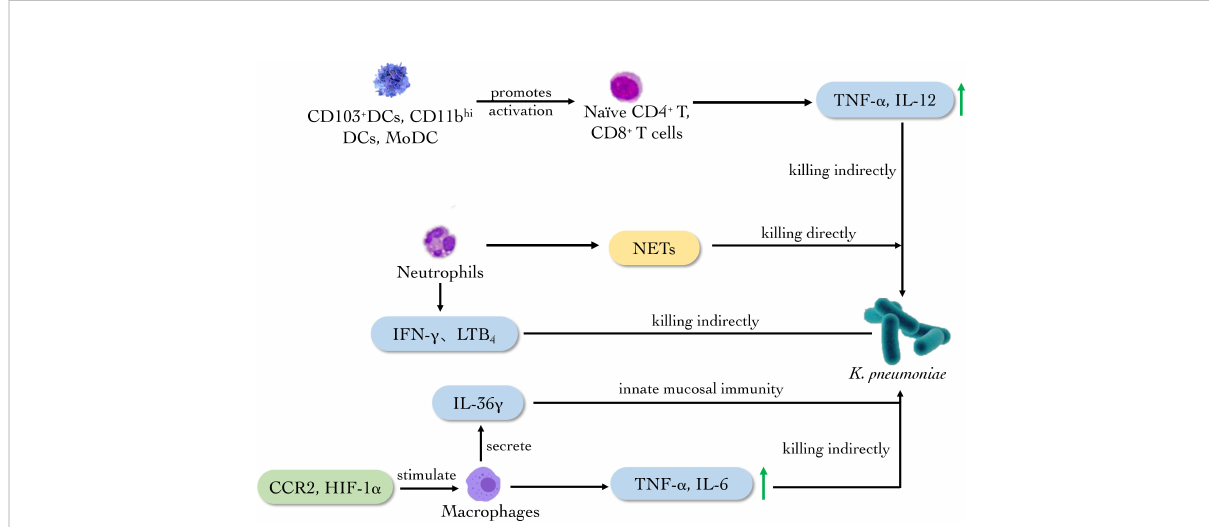
FIGURE 4 The main role of innate immune cells against K. pneumoniae . Neutrophils produce NETs to eliminate K. pneumoniae directly. Meanwhile, CD103 + DCs, CD11b hi and MODCs promote the activation of naïve T cells. CCR2 and HIF-1a activate macrophages to secrete cytokines such as TNF- a , IL-6 and IL- 36 g to eradicate the